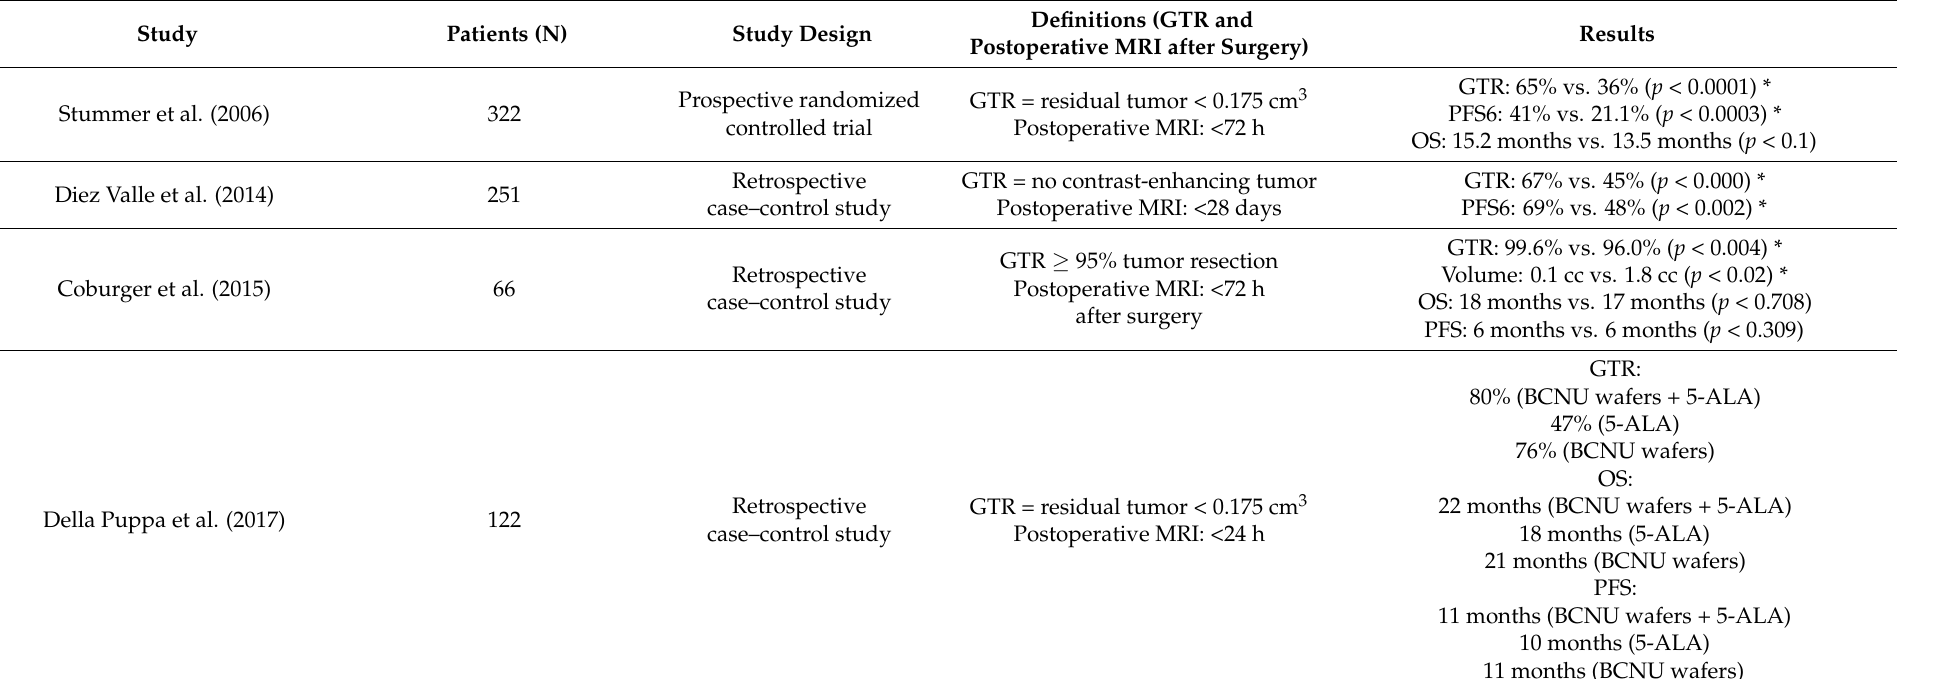
Table 1. HGG studies with 5-ALA-guided surgery compared to white light